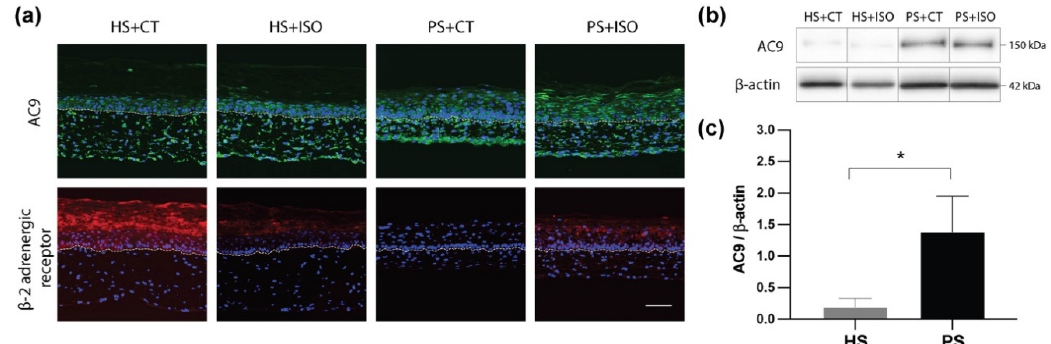
Figure 5. ( a ) Expression of adenylate cyclase 9 (AC9) (green) and β 2-adrenergic receptor (red) in healthy substitutes (HS) and psoriatic substitutes (PS) produced with cholera toxin ( + CT) or isoproterenol ( + ISO). The nuclei were stained with Hoechst (blue). The dotted line indicates the dermo-epidermal junction. Scale bar: 100 µ m. ( b ) Ten micrograms of total protein from skin substitute epidermis were analyzed by immunoblot for the presence of adenylate cyclase 9 (AC9). β -actin was used to control equal loading. ( N = 2 donors per condition; n = 2 skin substitutes per donor). One representative immunoblot is shown. ( c ) Densitometric analyses of the immunoblot from panel ( b ) ( N = 2 donors per condition; n = 2 skin substitutes per donor). Data from healthy or psoriatic substitutes were combined irrespective of treatment regime. The statistical significance was determined using an unpaired t -test (* p -value <